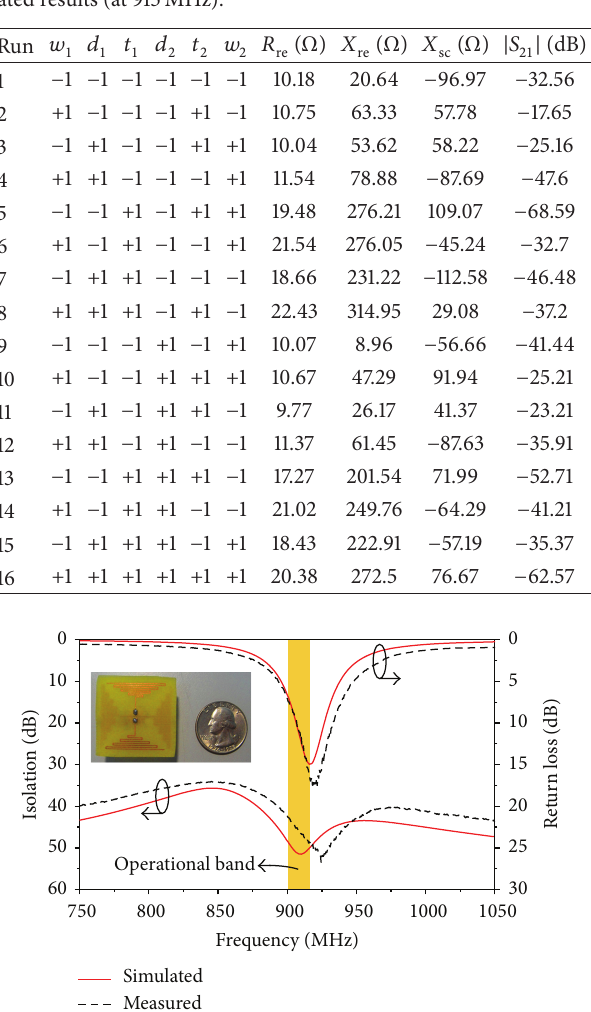
Table 6: The 2 6 – 2 orthogonal fractional experiment and the simu- lated results (at 915MHz).